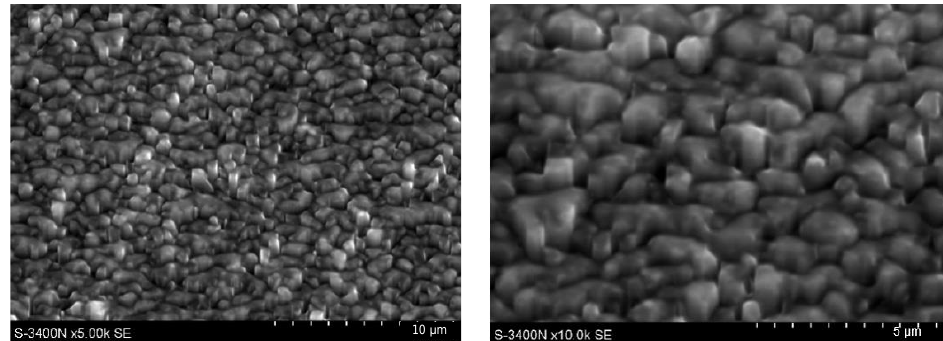
Figure 10. Microstructure of the WE43 alloy extruded using KoBo after compression at 400 °C and at a strain rate of 0.1 s -1 (ion etching).